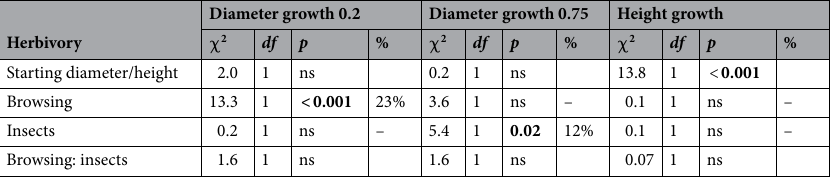
Table 1. ANOVA (type II) test results for linear mixed model testing the growth response (height and diameter (at both 0.2 m and 0.75 m stem height)) in relation to starting height/diameter and the herbivory treatments (browsing and insects) and their interaction, year one (2016) of the experiment. Significant p-values are marked in bold. The ‘%’ column shows the percentage difference in growth increment on trees exposed to browsing or insects compared to